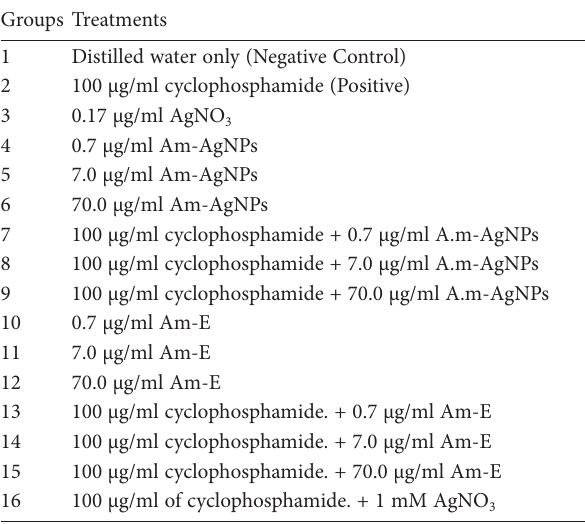
Table 1. Experimental Design of Cytogenotoxic Evaluation. Groups